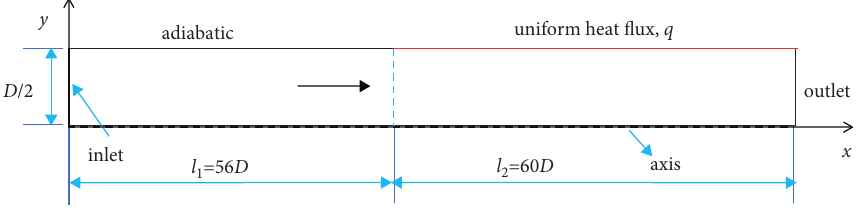
Figure 2: Test section of experiment for helium-xenon mixtures by Taylor et